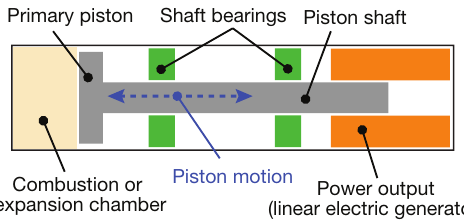
Figure 2. Generic FPE setup with single expansion piston (labeled as primary piston) and linear electric generator for electrical power output.